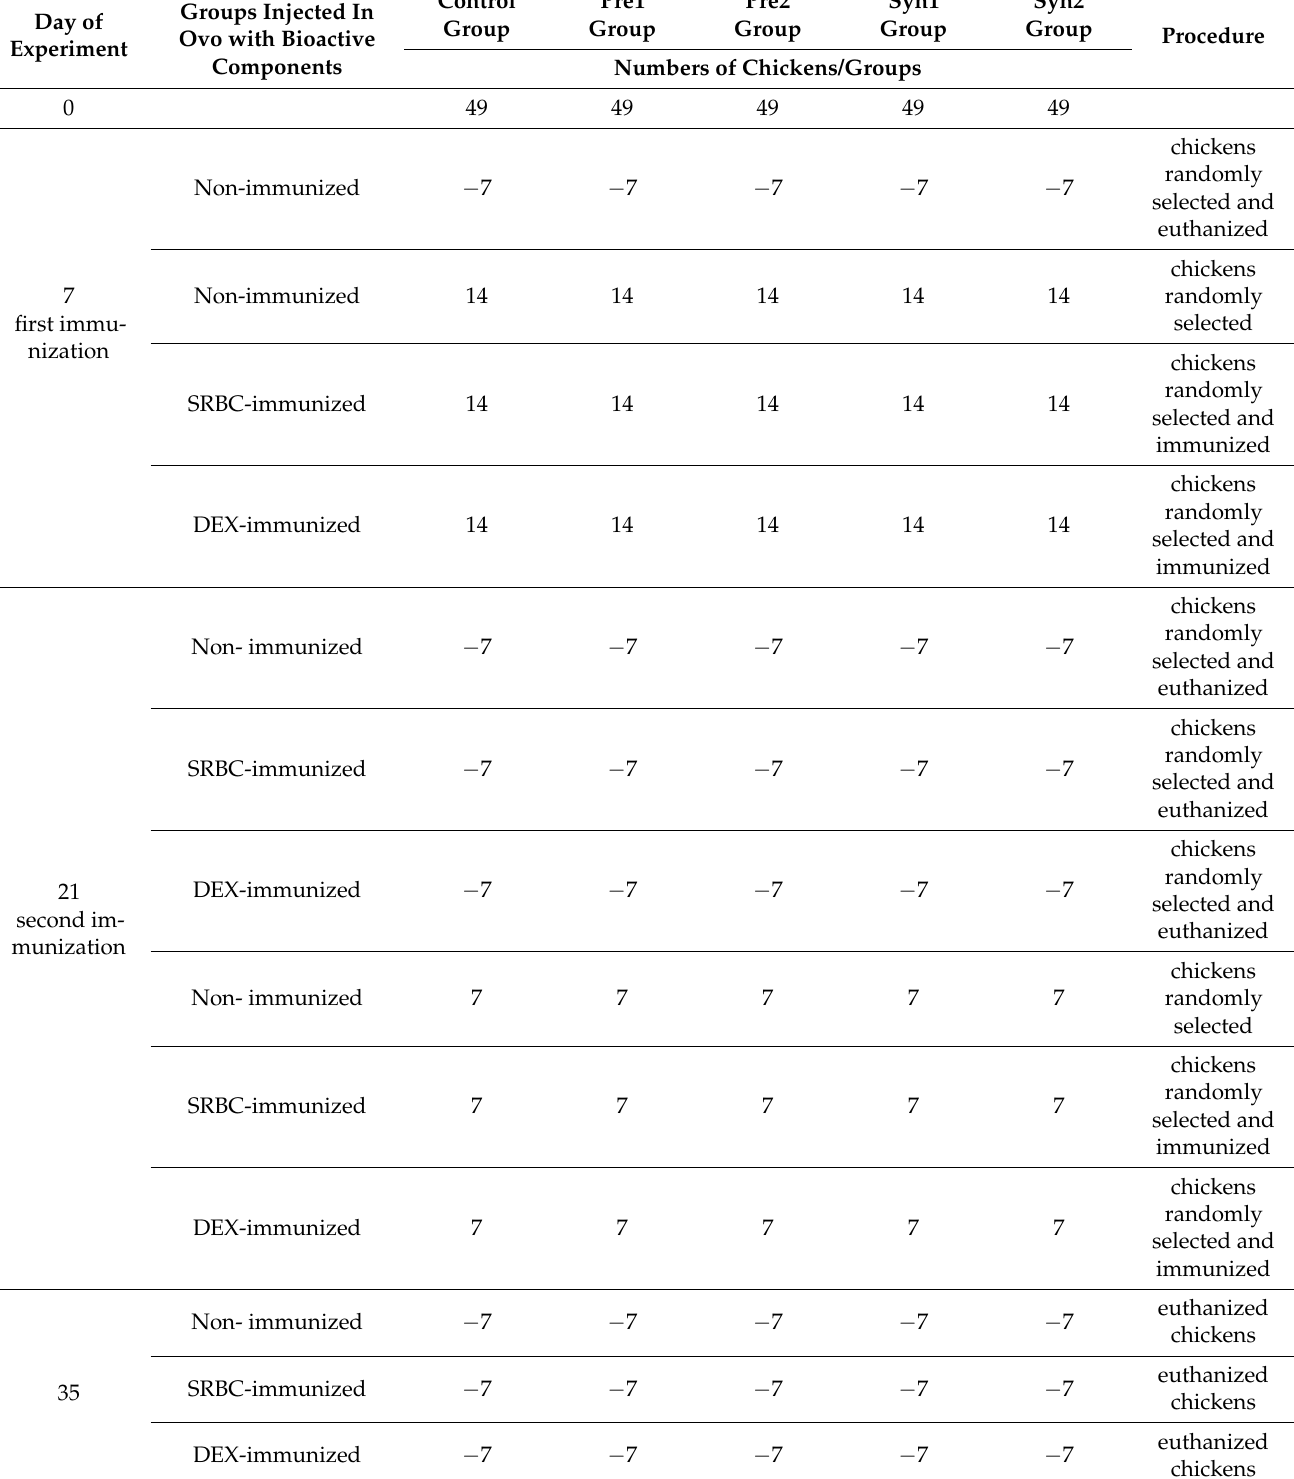
Table 1. The schedule of the